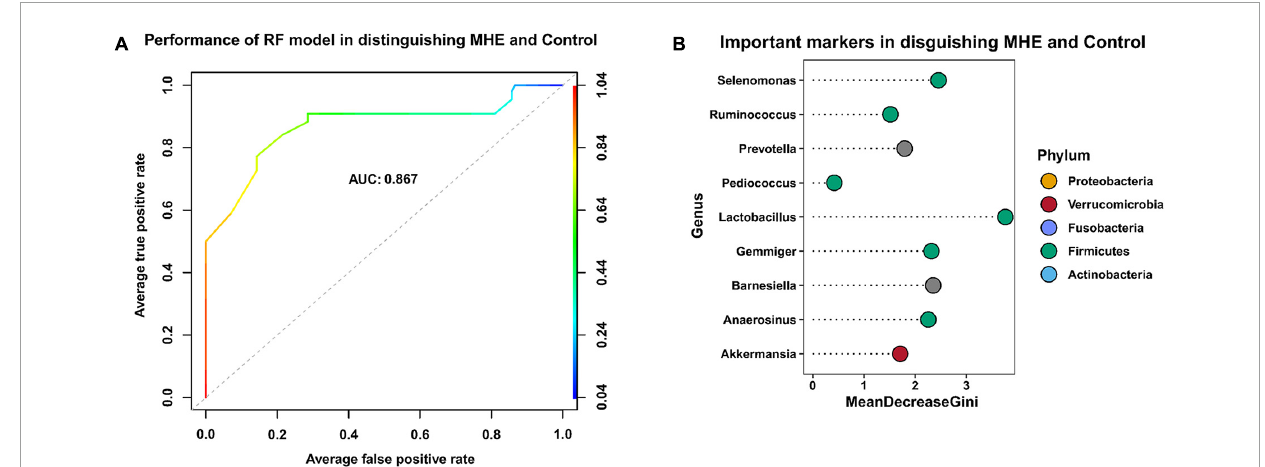
FIGURE6 Key taxa related to MHE. Receiver operating curve (ROC)-analysis showed the performance of random forest model in distinguishing MHE and control group (A) . The top 9 important taxa selected by random forest model (B) .